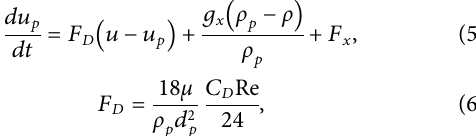
Frontiers in Earth Science |